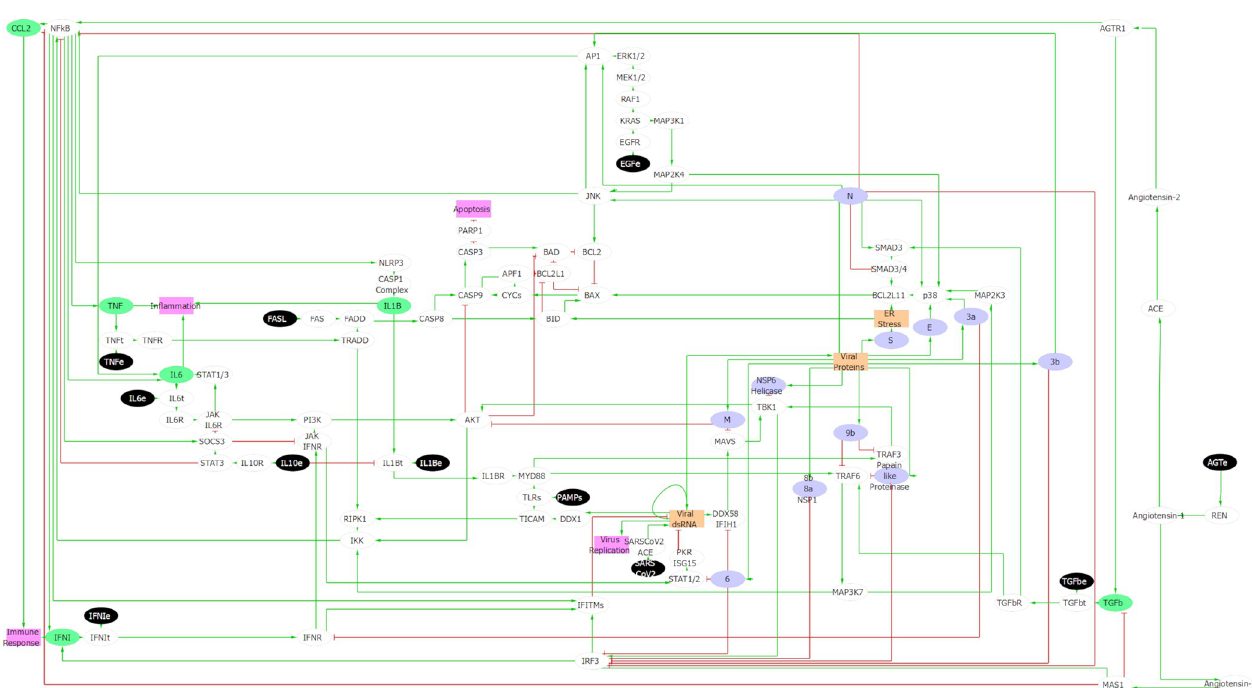
Fig 1. Regulatory network of COVID-19 infection. The response, controlled by the microenvironment, affects the cellular phenotypes through key molecular pathways. Inputs from the microenvironment are denoted in black, viral proteins are marked in violet, and cytokines in green. The phenotypic readouts Viral replication, Inflammation, Apoptosis and Immune response are indicated in pink. Inhibitions are denoted by red blunt arrows and activations by green arrows. Ellipsoidal components are associated with Boolean levels, whereas rectangles indicate multivalued level components.